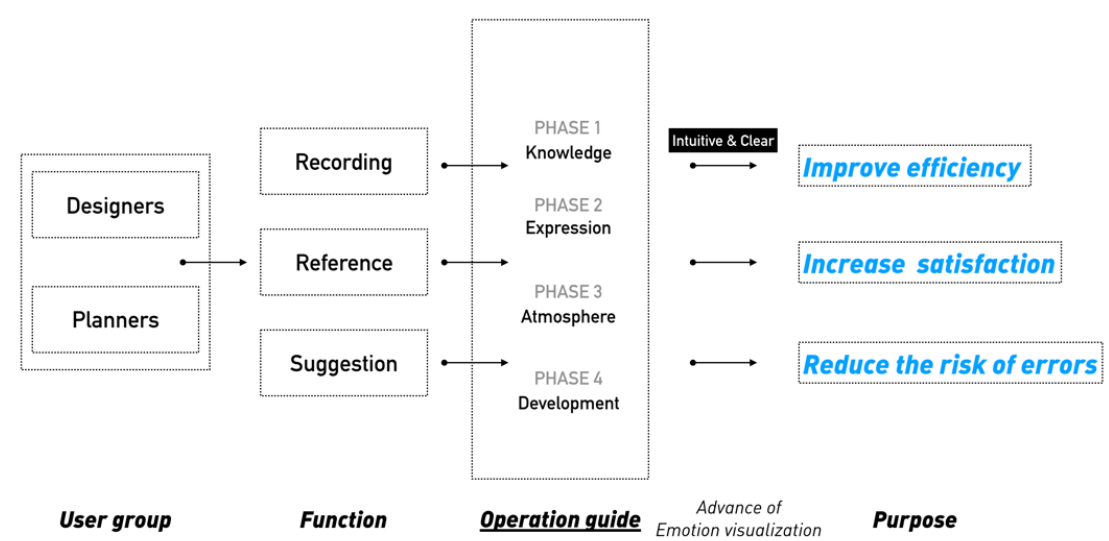
Figure 12. Visualisation methodology operation guide and purpose.